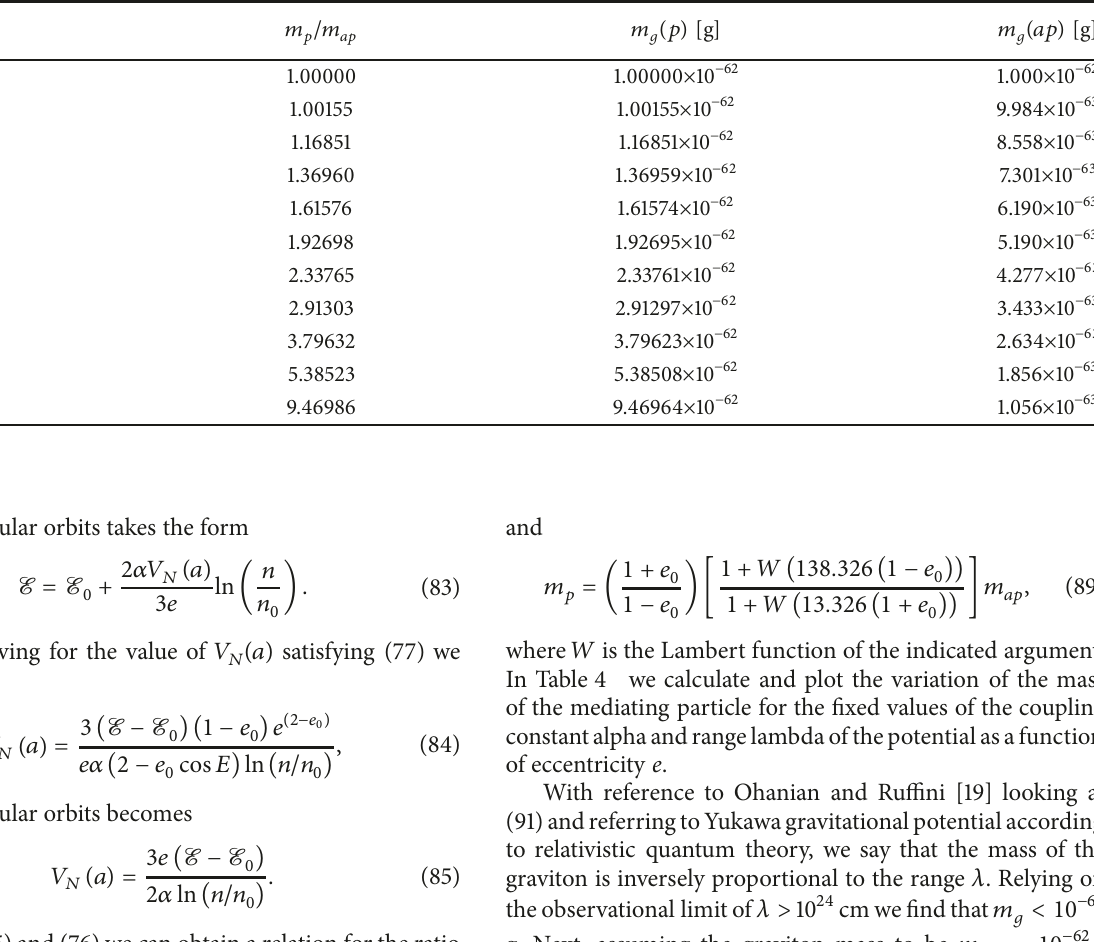
Table 5: Ratio of the mediating the interaction particle as a function of various eccentricities as is “felt” by the orbiting secondary body for 𝑄 0 =